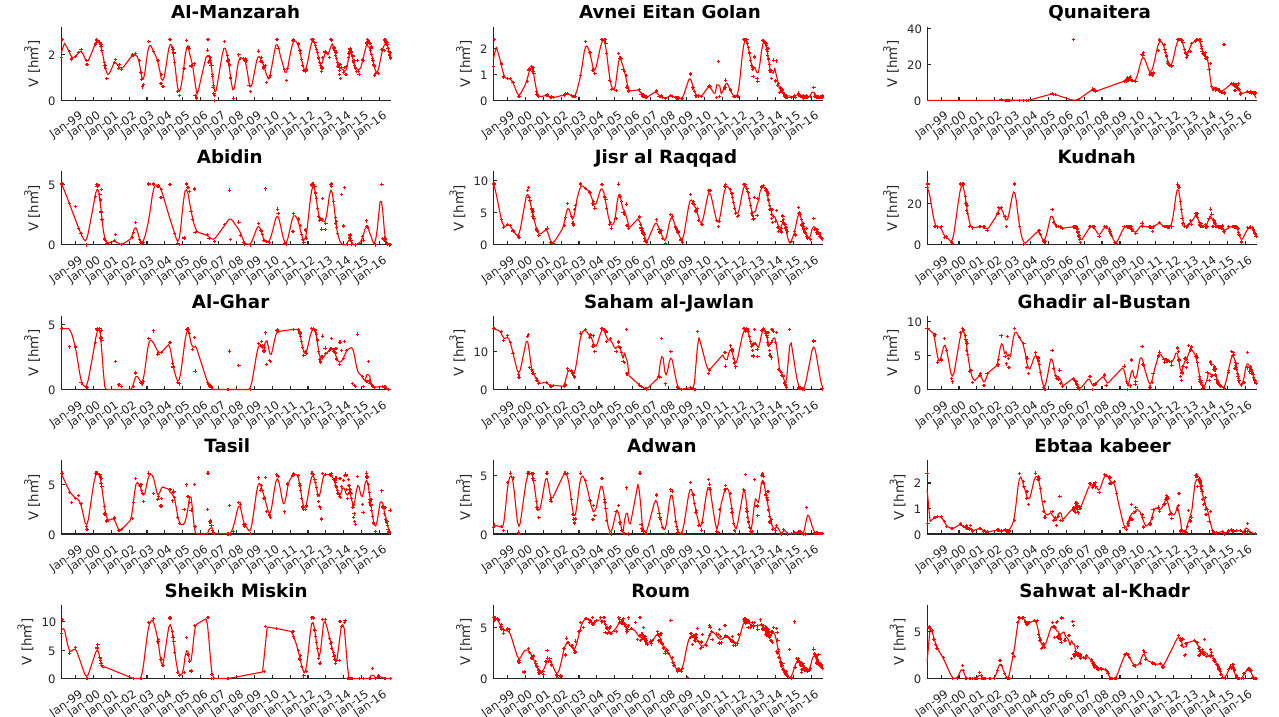
Figure 10. Storage variations. Red crosses indicate estimates from the method developed in this paper. Red lines are local polynomial regressions that are plotted only with the purpose of showing storage variation trends.